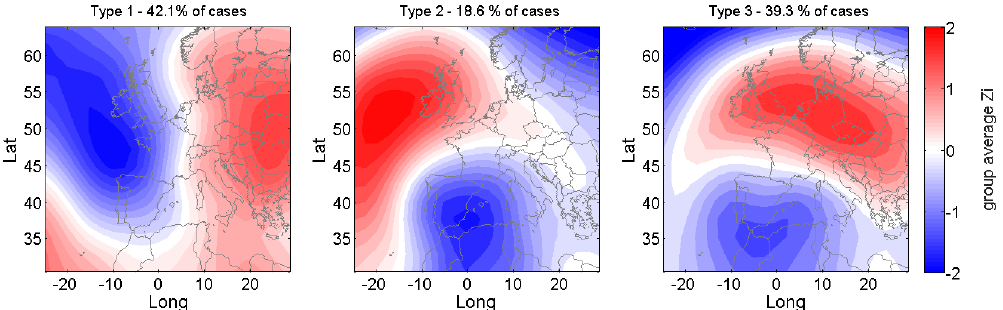
Figure 8. Synoptic types during the occurrence of compound extreme events along the Catalan coast based on the correlation between the 1000hPa geopotential fields (coloured shading). The group average Zi represents the mean number of positive or negative standard deviations from the mean at each grid cell i